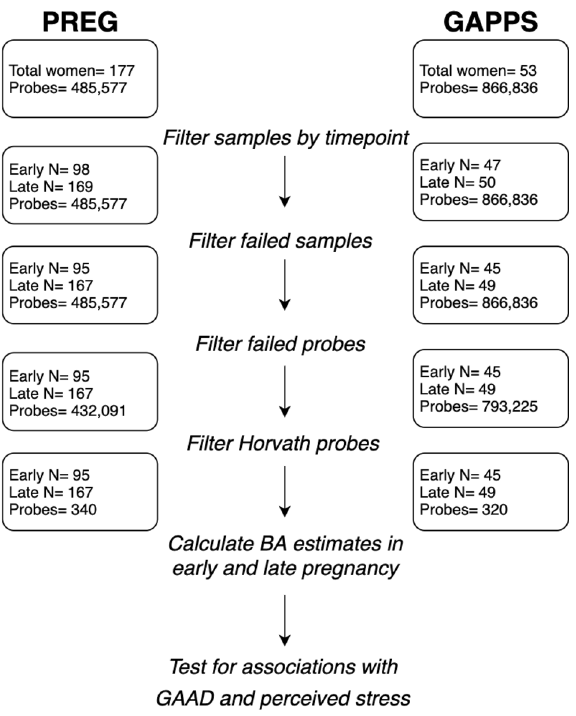
Figure 1. Diagram of study design and processing steps, highlighting probes and samples remaining in the primary (PREG) and replication (GAPPS) cohorts after performing quality control for DNA methylation microarrays. BA = Horvath-derived biological age estimates, GAAD = gestational age at